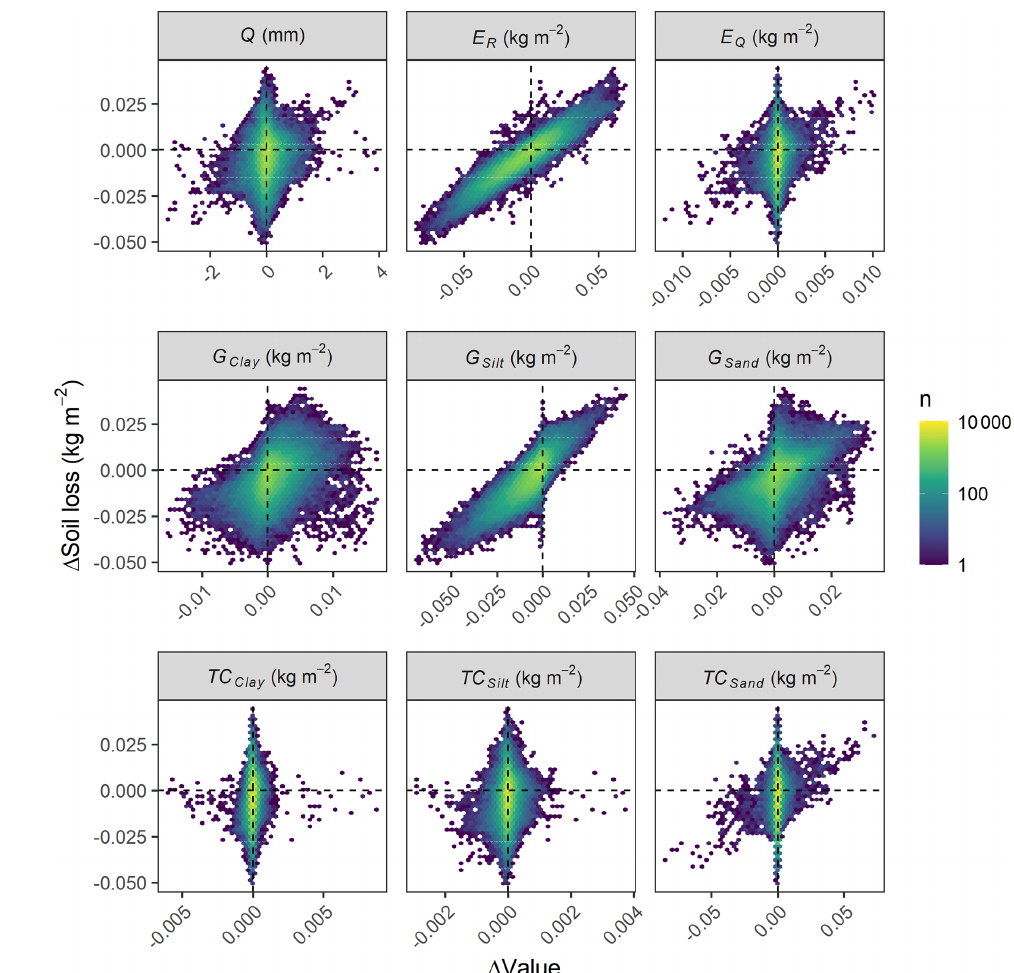
Figure 9. Hexagonal heatmaps and linear regression lines ( p < 0 . 00001) of the changes in soil loss over 10-year rolling means for the soil profiles. Colours represent the number ( n ) of cases in each